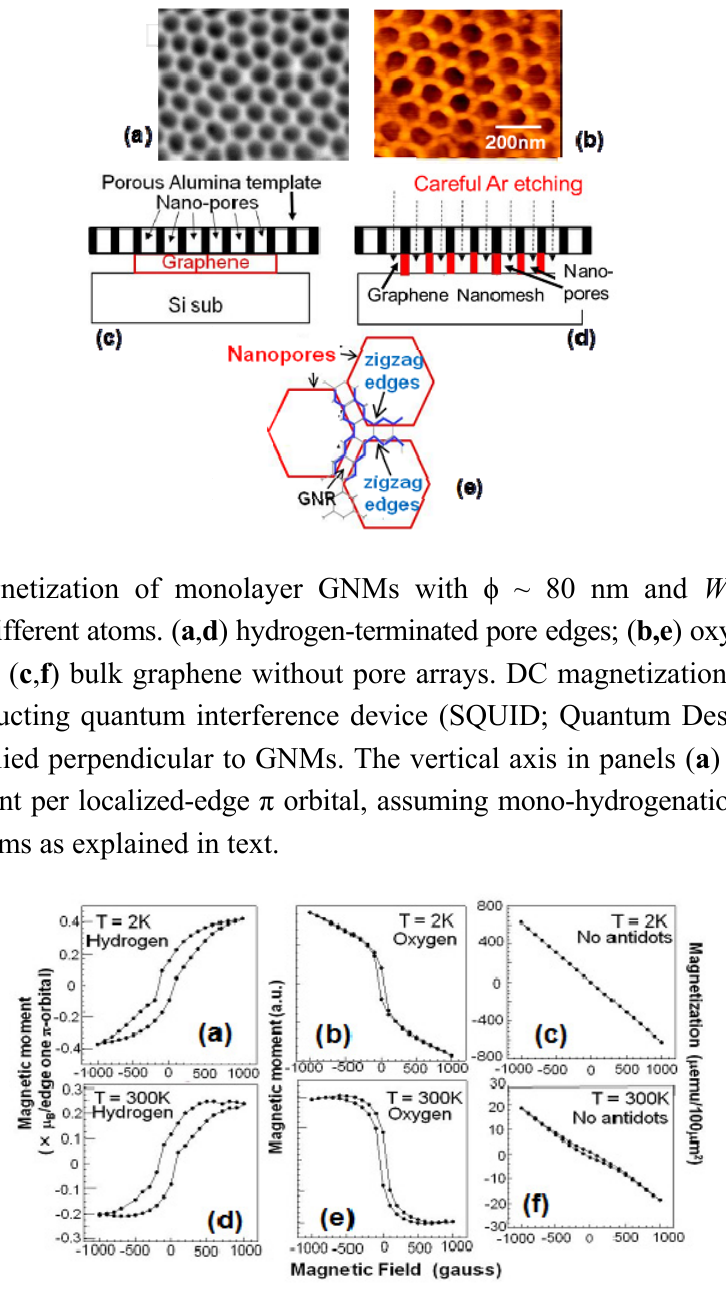
Figure 1. ( a ) SEM top view of a nano-porous alumina template (NPAT), which shows honeycomb-like array of hexagonal nano-pores; ( b ) AFM image of a graphene nanomesh (GNM) transferred following ( c ) and ( d ), which also proves the hexagonal shape of the pores (mean diameter ϕ ~ 80 nm and mean inter-pore distance W ~ 20 nm); ( c , d ) Schematic cross sectional views of nonlithographic fabrication process of a GNM; ( c ) NPAT was placed on graphene as an etching mask; ( d ) The graphene is carefully etched by Ar gas, resulting in formation of a GNM; ( e ) Schematic view of a GNM with the zigzag-type pore-edge. Interpore regions can correspond to GNRs. Actual interpore regions include a larger number of hexagonal carbon unit cells per inter-pore region with length ~40 nm and W ~ 20 nm. This GNM structure brings at least three large advantages as mentioned in the text.